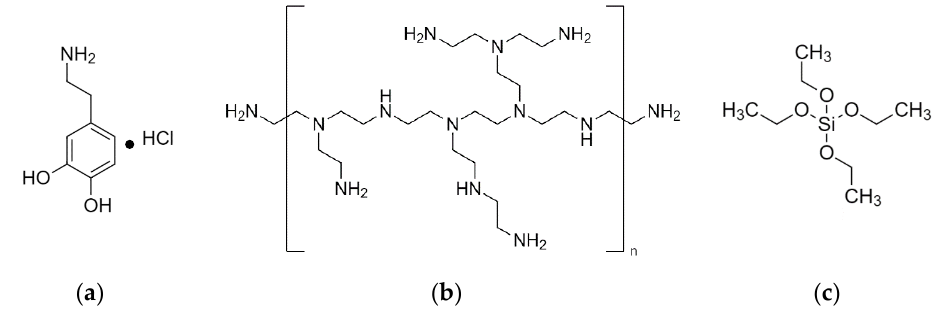
Figure 1. The chemical structure of: ( a ) dopa-HCl; ( b ) PEI; and ( c )